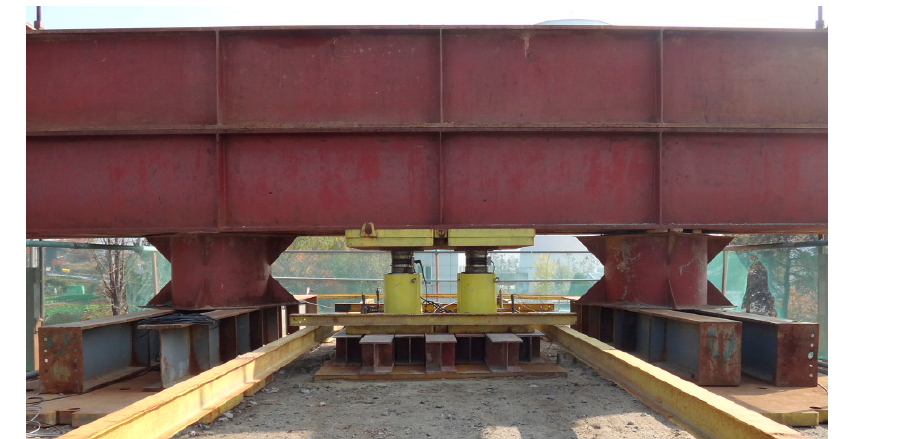
Figure 9. Foreground of loading system. Table 5. Loading test stage and loading